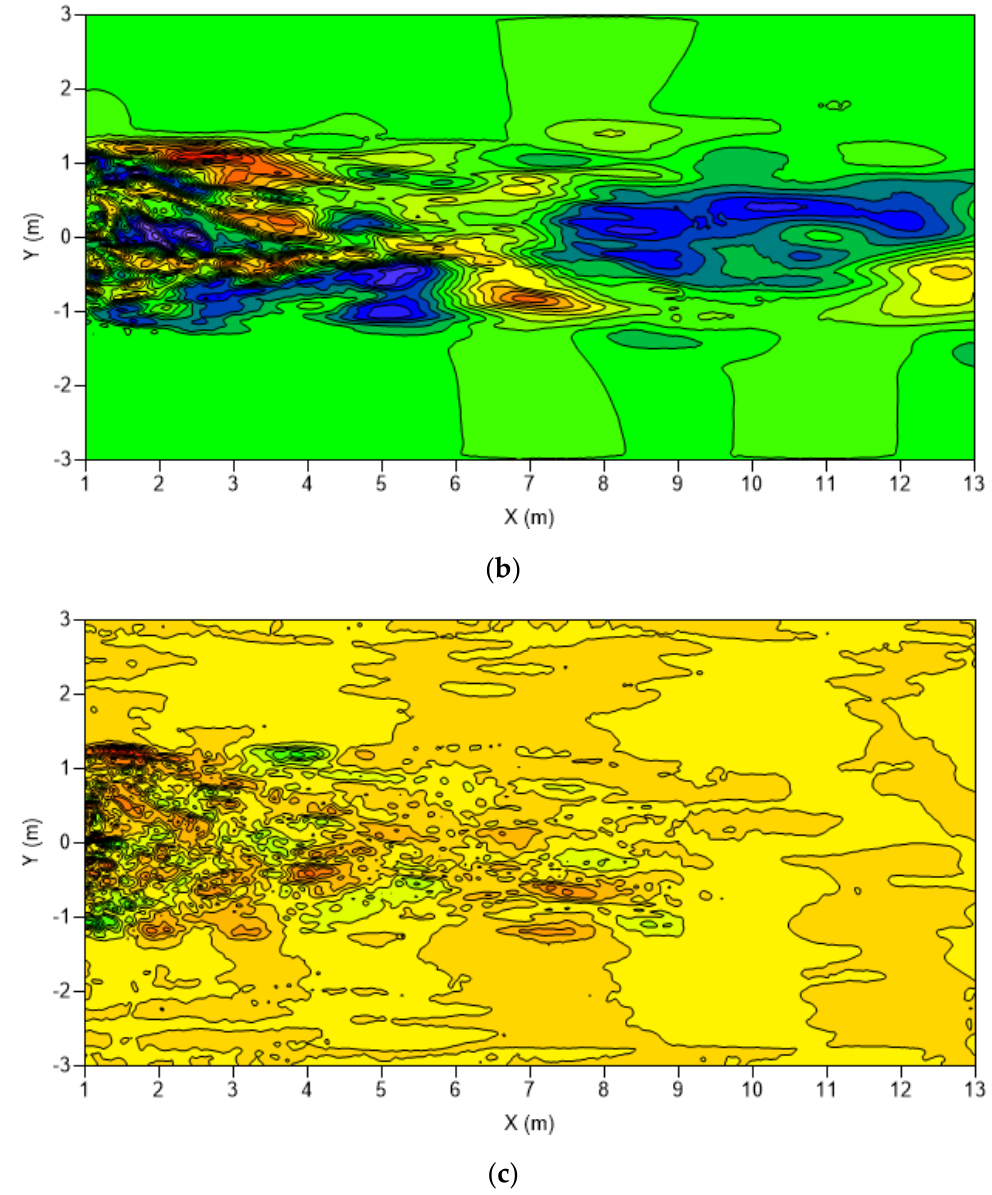
Figure A2. Φ 2 distribution in the wake region of healthy and damaged VAWTs: ( a ) Pressure-based, ( b ) Velocity-based ( c ) Vorticity-based